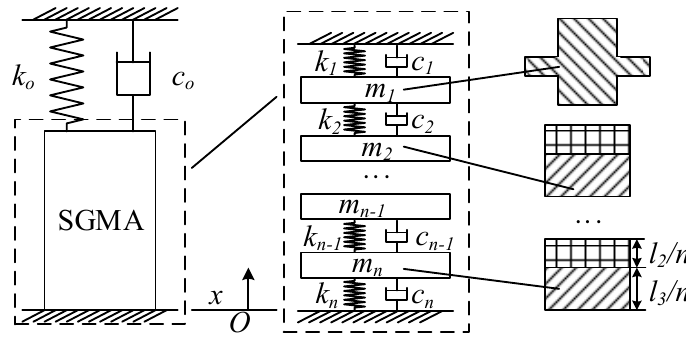
Figure 4. Multi-degree-of-freedom vibration system.